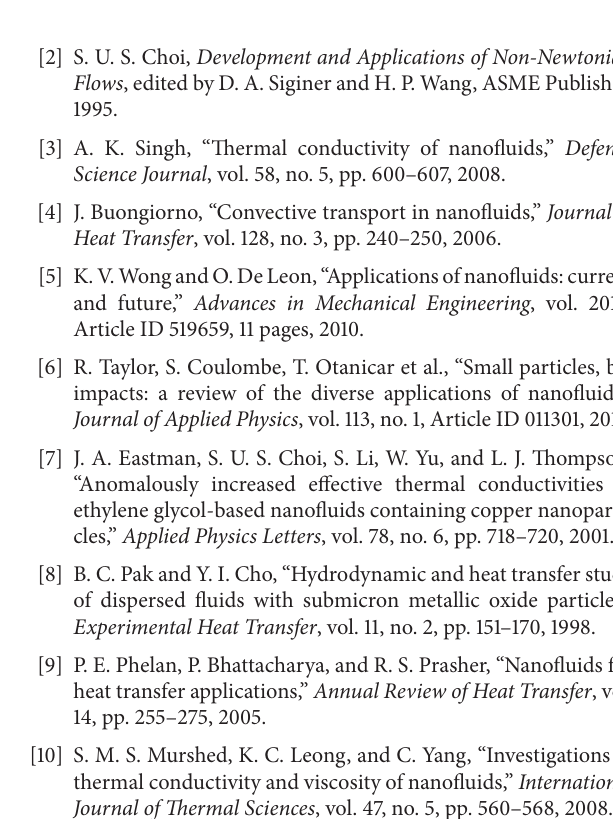
Figure 9: Optical microscopy images of alloy 110 copper before and after (112-hour) test with nanofluid of 2% alumina in 50/50% ethylene glycol/water (magnification: 5000x). Preexisting pitting and enlarged ones after treatment are